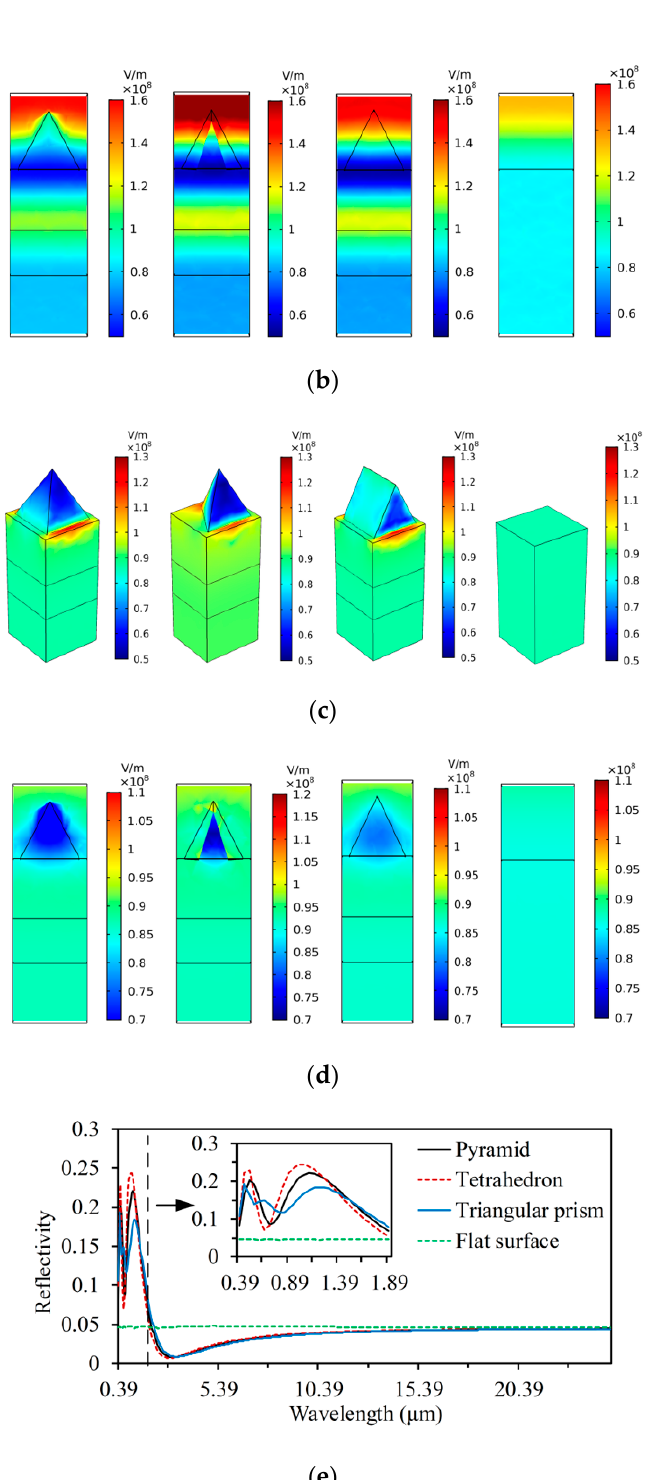
Figure 6. Numerical results of spectral characteristics of biomimetic micro-nano structures based on pyramid (I), tetrahedron (II), triangular prism (III) and flat surface (IV) with air gap for comparison.